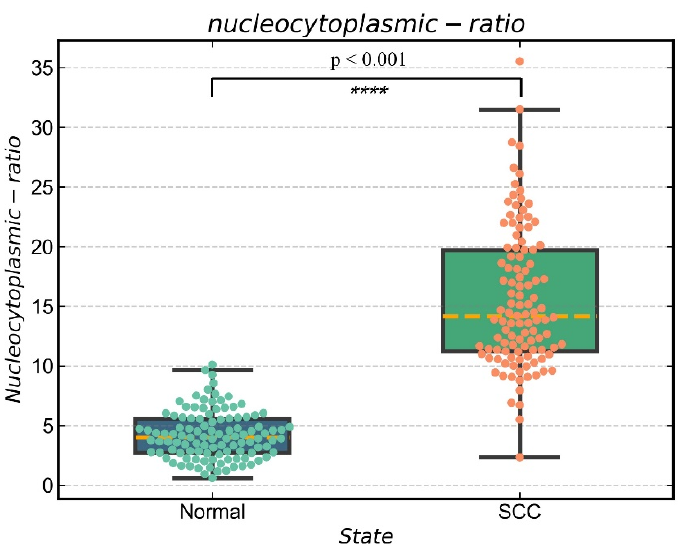
Figure 6. Values of nucleocytoplasmic ratio were expressed as average, maximum and minimum. Comparisons between two groups were performed using Student’s t -tests; **** p < 0.05.